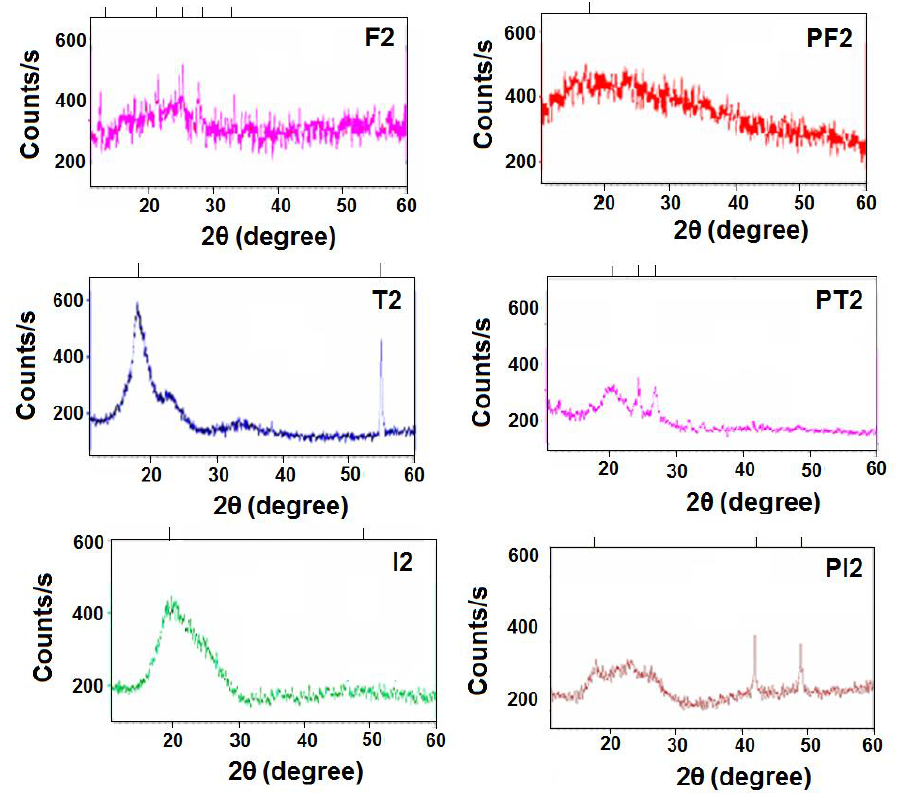
Figure 4. WXRD patterns of the representative terpolyamides and their corresponding block copolymers.